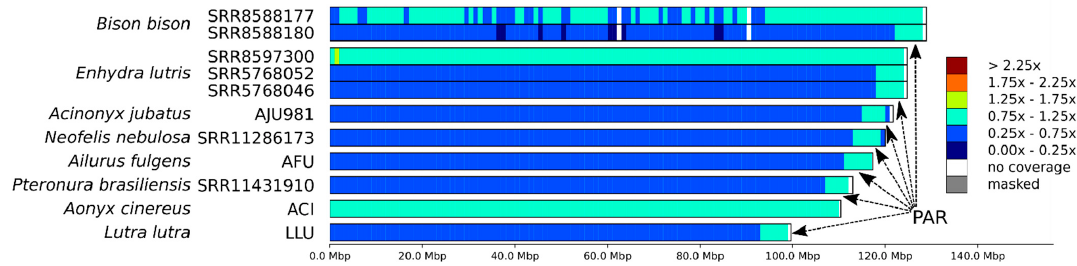
Figure 4. The depth of coverage along the identified X chromosome in eight mammal species (Table 1). The dark blue color corresponds to a half coverage (0.25 × –0.75 × genome coverage, and the teal-colored fragments are covered at 1 ×